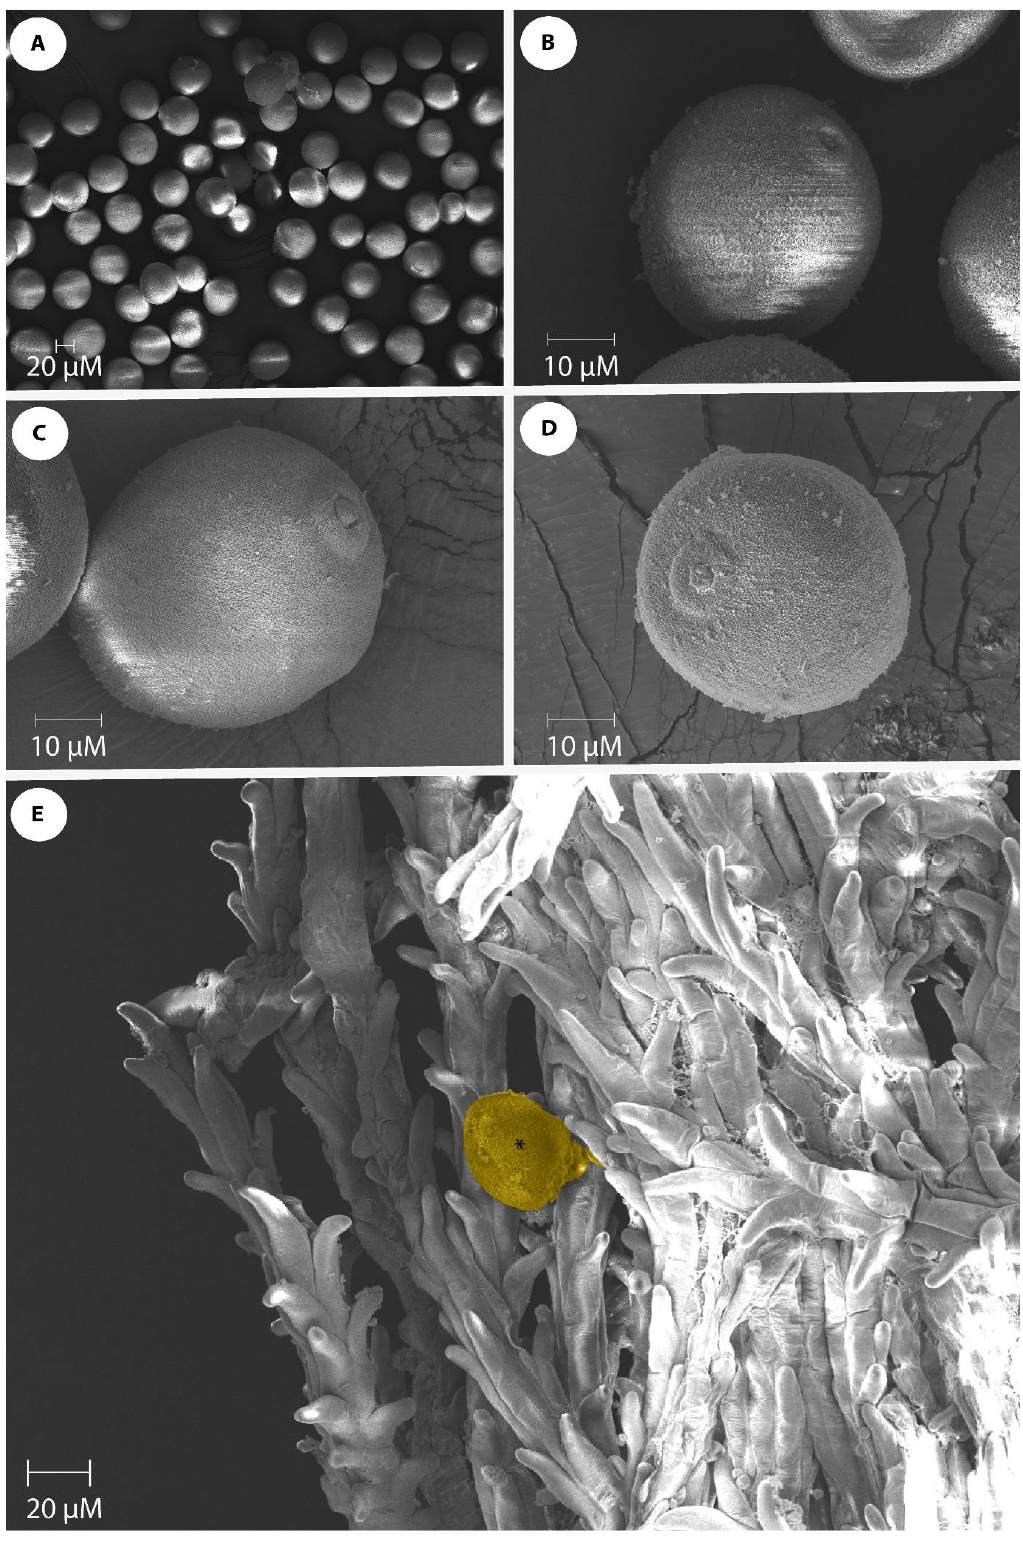
Figure 2. Wheat pollen grains of wheat genotypes. ( A ) Monoporate wheat pollen grains; ( B ) Equato- rial view of Gladius+Sr50 pollen showing 5 µ m surface aperture; ( C ) Equatorial view of Thatcher pollen showing 4 µ m aperture size; ( D ) Slightly oblique polar view of Lilian pollen with 3 µ m aperture size; ( E ) Pollen germination (indicated by an asterisk) on the feathery branched stigmatic surface. Scale bars are shown on each SEM